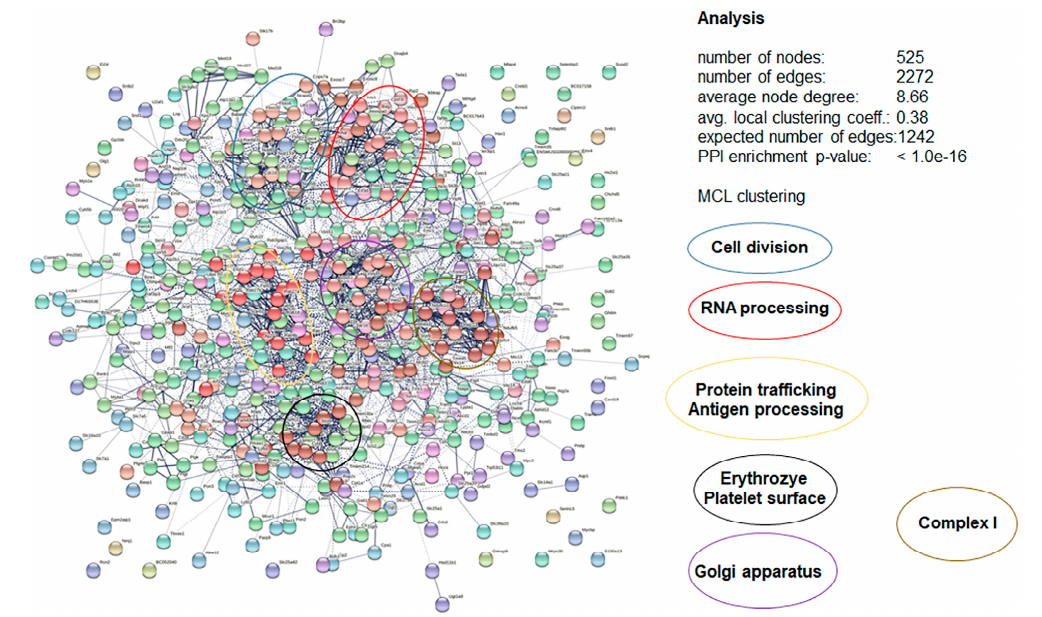
Figure 10. Protein–protein interaction network of proteins specifically binding to peptide 6027 in cell-free extracts of mouse spleens. Five clusters, namely cell division (blue), RNA processing (red), protein trafficking and antigen processing (yellow), erythrocyte and platelet surface (black), golgi apparatus (pink) and respiratory chain complex I (brown) are surrounded by ellipses. The interaction network was created by the STRING knowledge base and software tool from the Swiss Institute of Bioinformatics (www.expasy.org).